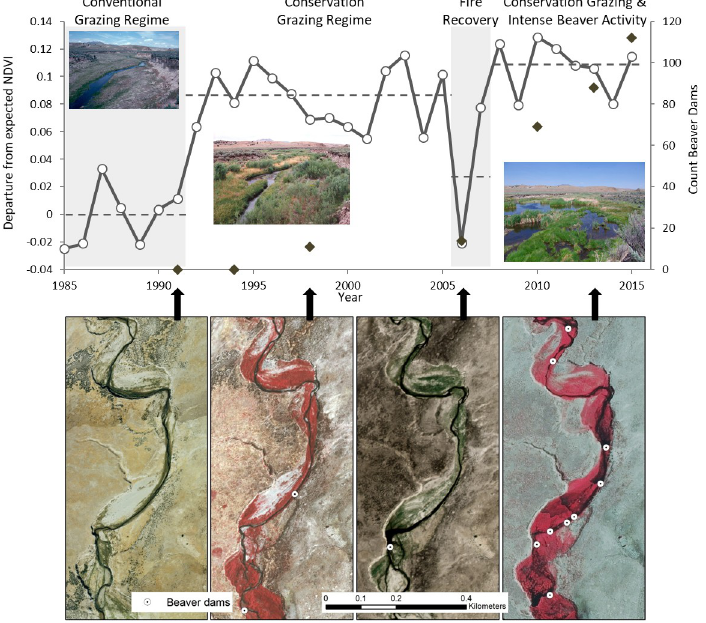
Fig 4. Time series of riparian vegetation recovery. Top panel: Departure from expected NDVI under conventional grazing regimes and 0 beaver (solid line, left y-axis) and beaver dam count (diamonds, right y-axis) time series data for the Susie Creek riparian pasture in the Carlin Field allotment. Departure from expected NDVI by year is represented using each year’s residual from the linear relationship between NDVI and water year precipitation for Susie Creek watershed observation units with conventional grazing regime, no wildfire effects, and 0 beaver dam observations. Negative departure values indicate lower than expected NDVI values given that year’s precipitation; positive values indicate higher than expected NDVI. Average NDVI departure for 4 treatment and condition periods shown with dashed lines. Bottom panel: Example aerial photos from a portion of the pasture from 1991, 1998, 2006, and 2013 showing riparian vegetation extent and beaver dams. Aerial photos are reprinted from USDA Farm Service Agency and site photographs are reprinted from US Bureau of Land Management, both under a CC BY license (public